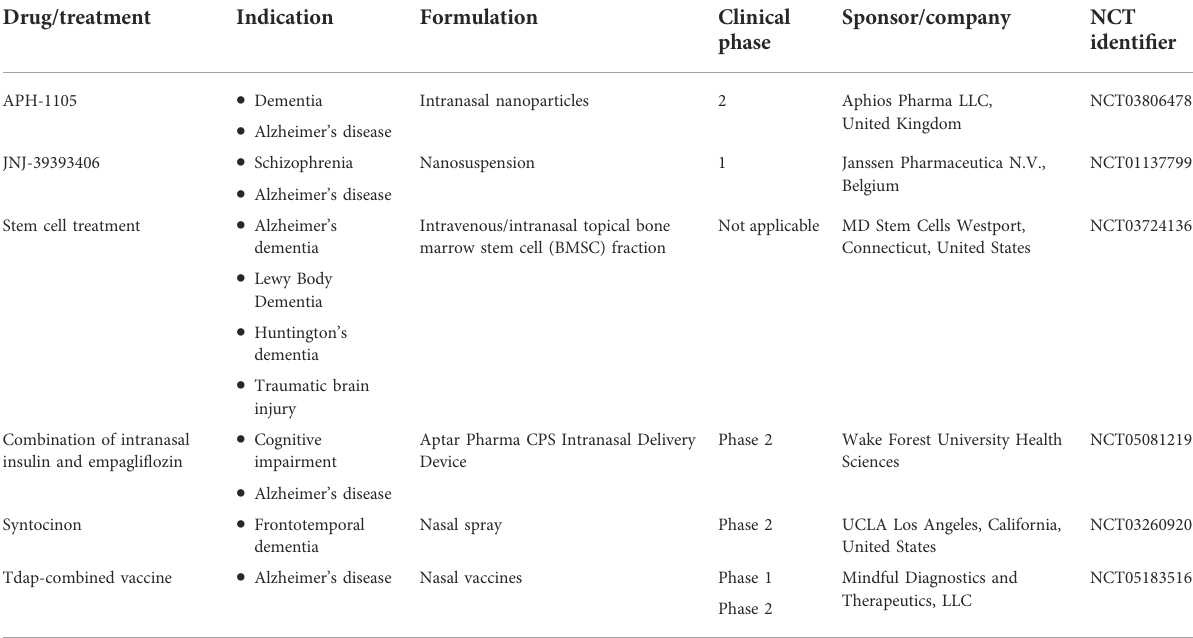
TABLE 1 Clinical status of nanocarriers in Alzheimer ’ s disease (AD) treatment (Clinical Trials.gov database, 2022).